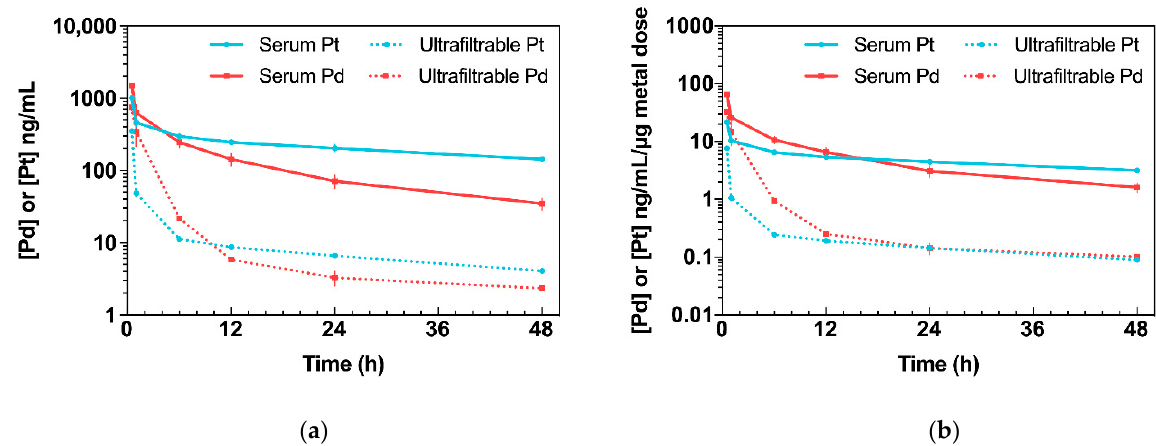
λ z = elimination rate constant; T max = time to reach C max ; C max = mean maximum concentration ± SEM; AUC 0 − 48h = area under curve from time zero to 48 h; AUC 0 − ∞ = area under the curve from time zero to infinity; Vz/F = volume of distribution at terminal phase; CL/F = body clearance.